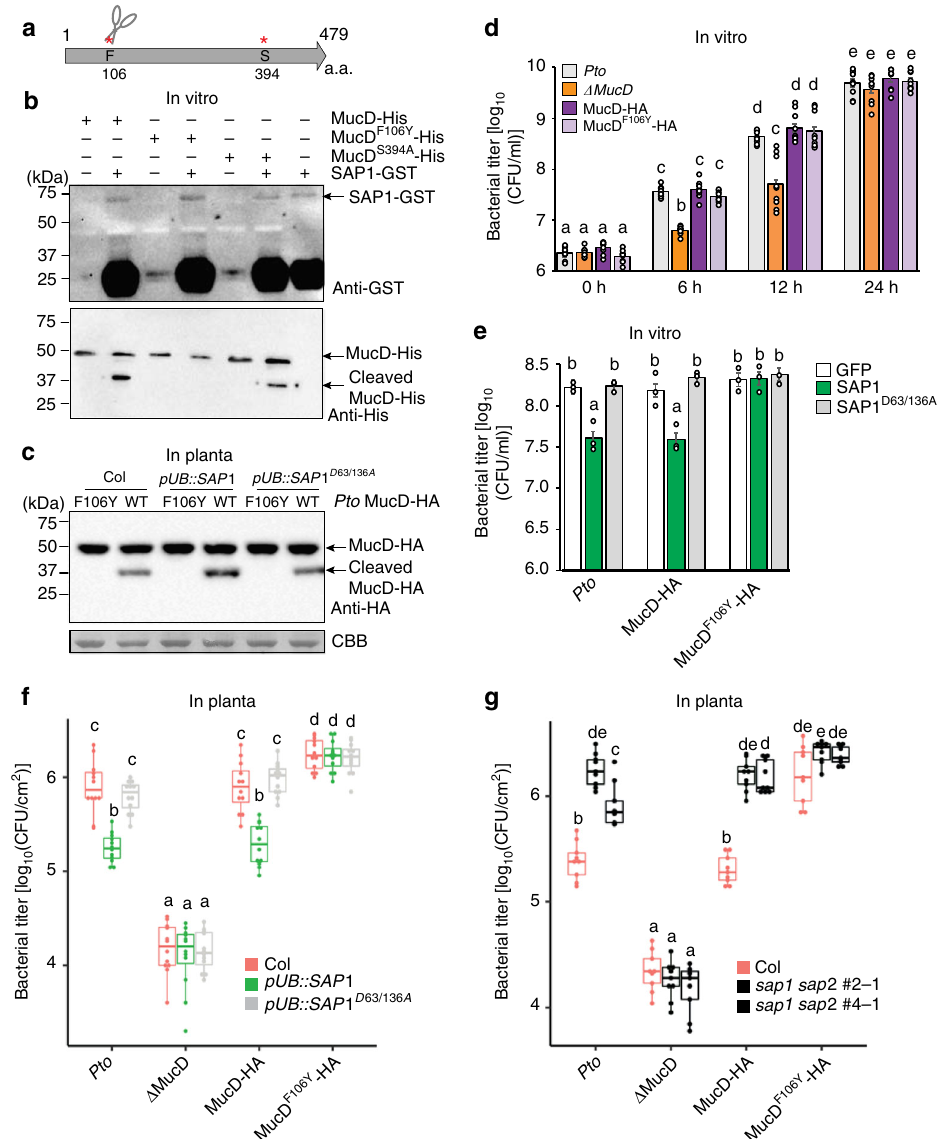
Fig. 4 Secreted aspartic protease (SAP)-mediated cleavage of MucD suppresses Pto growth. a Schematic diagram of putative aspartic protease cleavage sites in MucD. The phenylalanine (F) and serine (S) residues were replaced with tyrosine (Y) and alanine (A), respectively. b MucD-His, MucD F106Y -His, and MucD S394A -His proteins were incubated with SAP1-GST. MucD-His or SAP1-GST was visualized by immunoblotting using an anti-HA or anti-GST antibody, respectively. Three independent experiments were performed with similar results. c Pto Δ mucD expressing MucD-HA and MucD F106Y -HA (OD 600 = 0.05) was in fi ltrated into leaves of 4-week-old Col, pUB::SAP1-RFP , and pUB::SAP1 D63/136A -RFP plants. MucD-HA was detected by immunoblotting at 6 hours post infection. Experiments were repeated at least three times with similar results. d In vitro growth of Pto , Pto Δ mucD , and Pto Δ mucD expressing MucD-HA, MucD F106Y -HA, or MucD S394A -HA (OD = 0.005) over time. Data represent means and s.e.m. of three independent 600 experiments each with three biological replicates. e In vitro growth of Pto (OD 600 = 0.05) supplied with puri fi ed recombinant proteins at 9 h after culturing. Data represent means and s.e.m. of three independent experiments with four biological replicates. f , g Pto , Pto Δ mucD , and Pto Δ mucD expressing MucD- HA or MucD F106Y -HA were in fi ltrated into leaves of 4-week-old Col, pUB::SAP1-RFP , pUB::SAP1 D63/136A -RFP , and sap1 sap2 plants, and bacterial titer was determined at 2 days post infection (dpi). Bars represent means and s.e.m. of three independent experiments with at least three biological replicates. d – g Statistically signi fi cant differences are indicated by different letters (adjusted P <